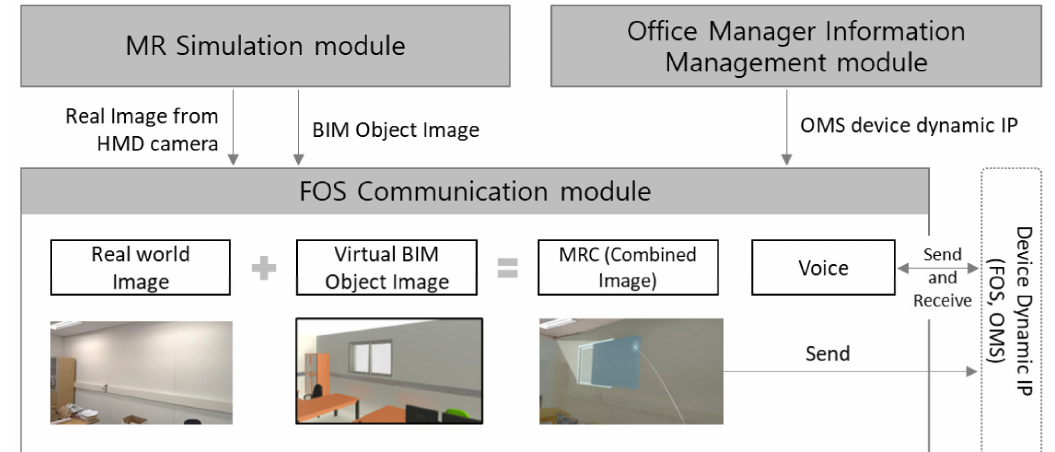
Figure 5. Functions of FOS